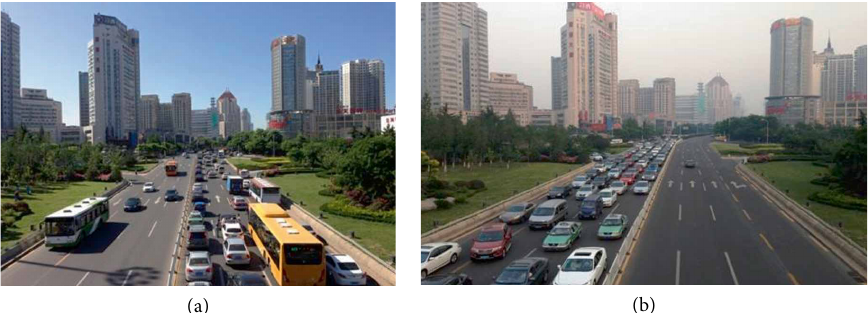
Figure 12: Distribution of housing in urban area.